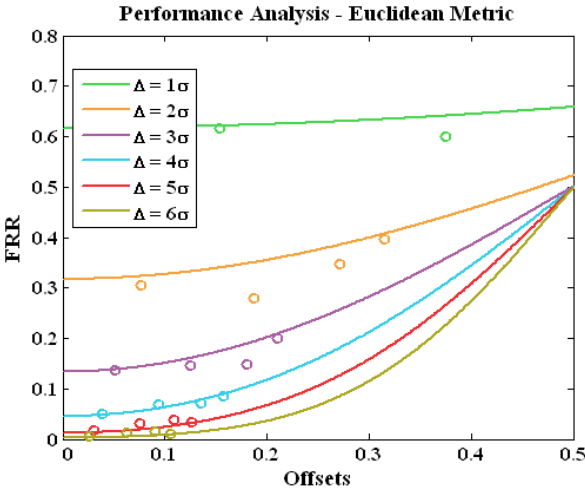
Figure 6. FRR of a location